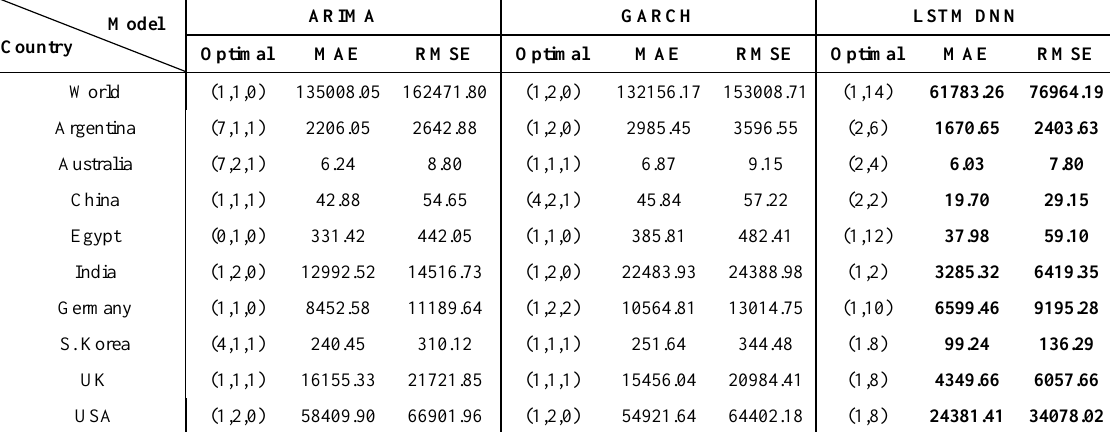
Table 3. Comparison of best MAE and RMSE with optimal parameters ( r = 0.8)